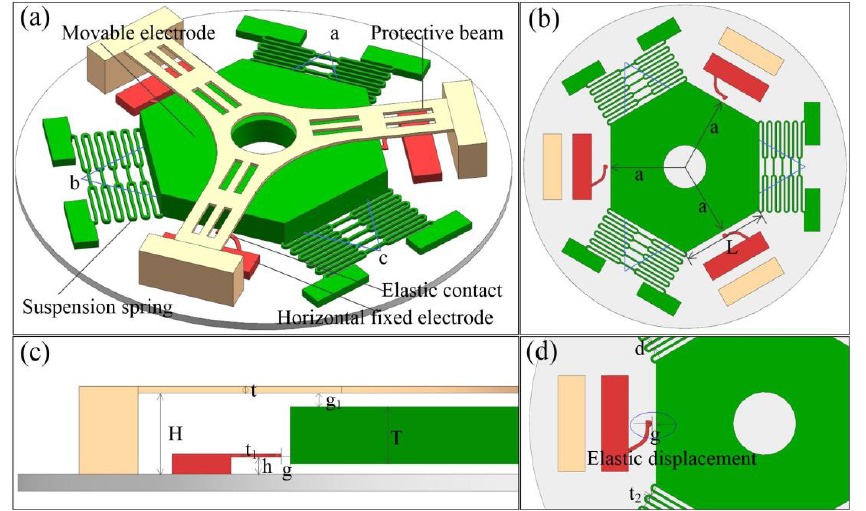
Figure 1. The structure of the designed three-axis inertial switch. ( a ) the 3D structure diagram of the inertial switch; ( b ) the top view of the structure; ( c ) one half of a lateral view of the structure; ( d ) the elastic fixed electrode.